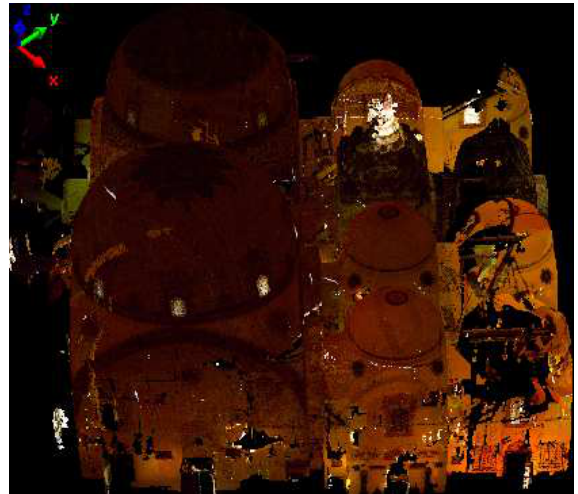
Figure 6. The inside 3D point cloud model with